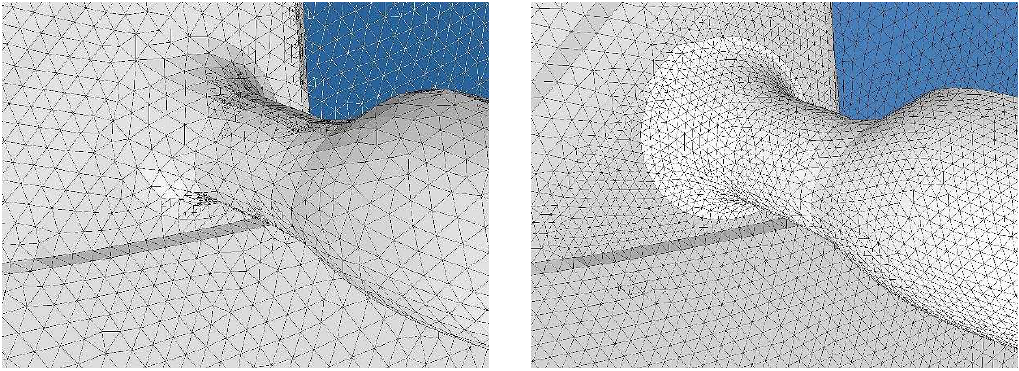
Figure 5 Mesh Resolution for sideview